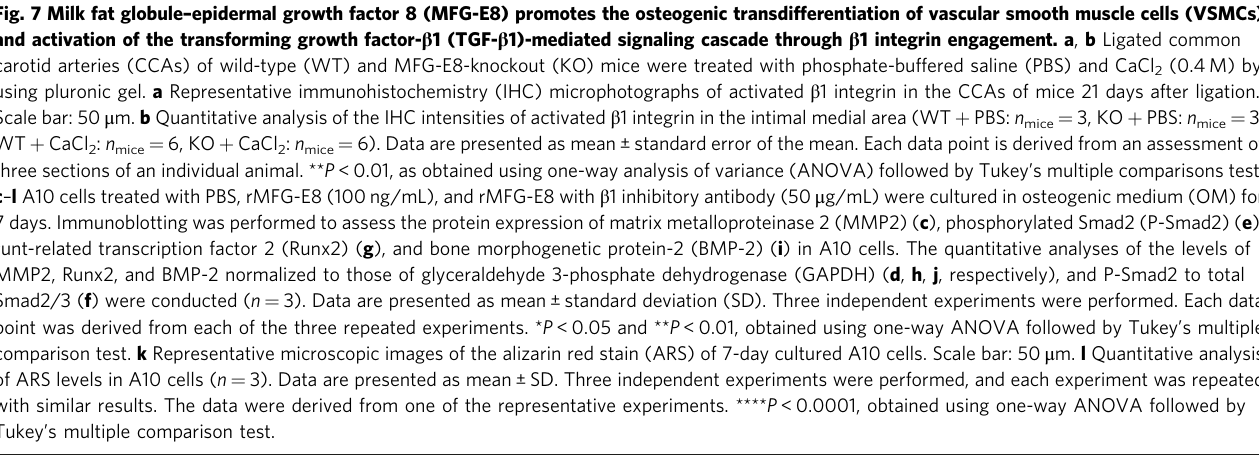
Fig. 7 Milk fat globule – epidermal growth factor 8 (MFG-E8) promotes the osteogenic transdifferentiation of vascular smooth muscle cells (VSMCs) and activation of the transforming growth factor- β 1 (TGF- β 1)-mediated signaling cascade through β 1 integrin engagement. a , b Ligated common carotid arteries (CCAs) of wild-type (WT) and MFG-E8-knockout (KO) mice were treated with phosphate-buffered saline (PBS) and CaCl 2 (0.4 M) by using pluronic gel. a Representative immunohistochemistry (IHC) microphotographs of activated β 1 integrin in the CCAs of mice 21 days after ligation. Scale bar: 50 μ m. b Quantitative analysis of the IHC intensities of activated β 1 integrin in the intimal medial area (WT + PBS: n mice = 3, KO + PBS: n mice = 3, WT + CaCl 2 : n mice = 6, KO + CaCl 2 : n mice = 6). Data are presented as mean ± standard error of the mean. Each data point is derived from an assessment